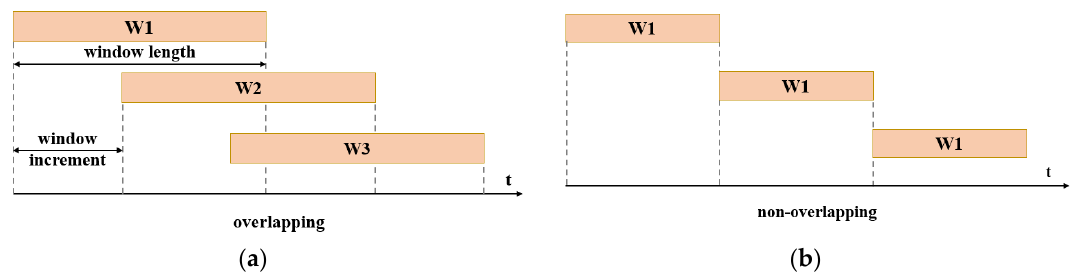
Figure 13. A conceptual depiction of: ( a ) the overlapping windowing method. ( b ) the non-overlapping windowing method.